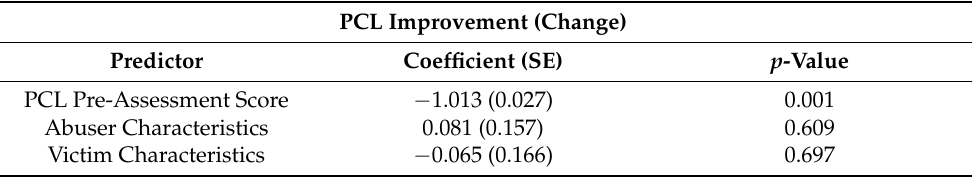
Table 4. Predictors of PCL improvement (change) based on victim and abuser characteristics. PCL Improvement (Change) Predictor p